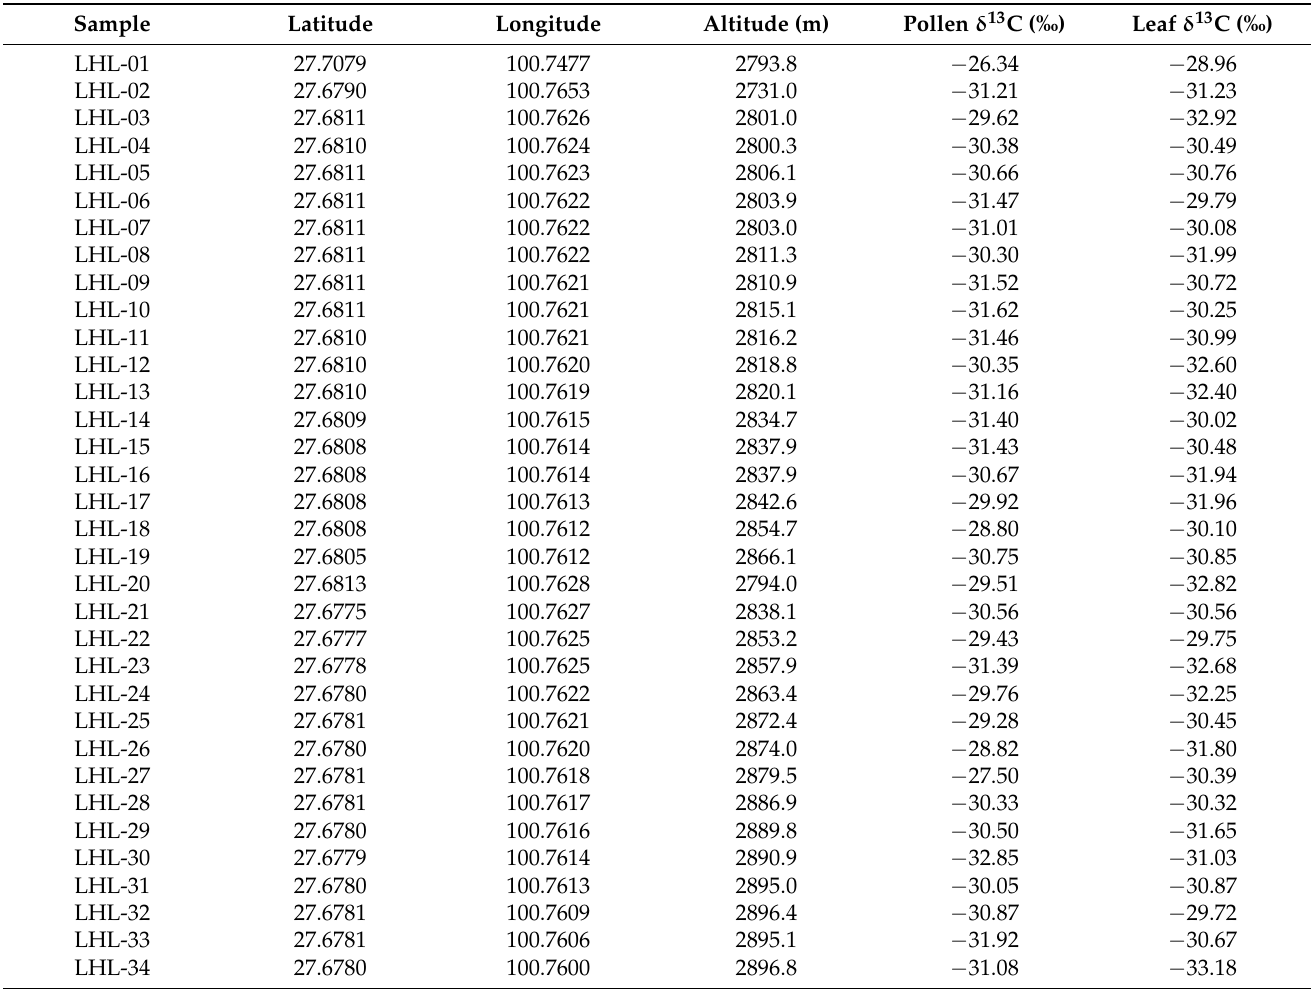
Table 1. Results of stable carbon isotope analysis on pollen and leaf samples ( n =